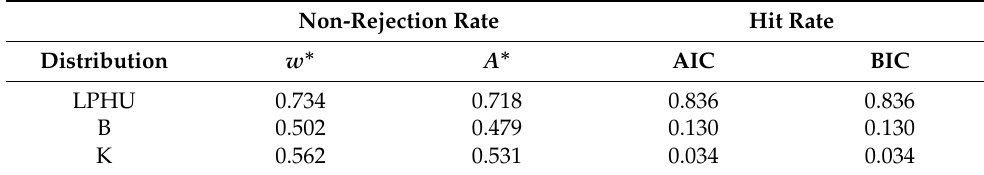
Table 2. Non-rejection rates based on modified AD ( A ∗ ) and CvM ( W ∗ ) statistics and hit rates based on AIC and BIC values for the LPHU, B, and K distributions fitted to the 1000 samples obtained from the household shared budget proportion data.